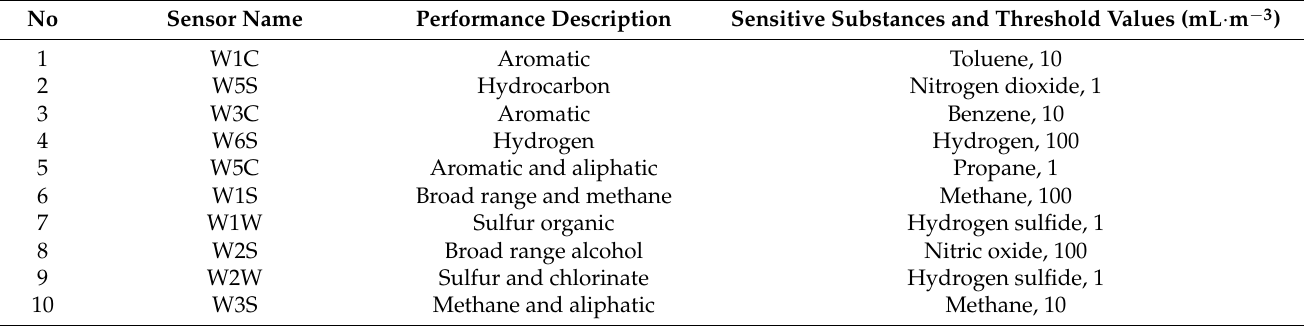
Table 1. Sensor description of